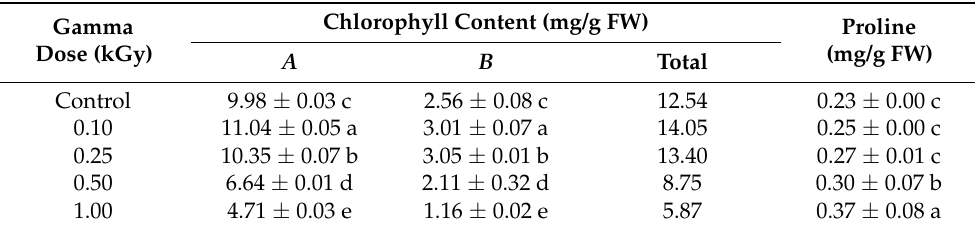
Table 7. Effect of gamma irradiation on chlorophyll (a and b) and total proline content of wheat, T. vulgare leaves in 2020/2021 growing season.